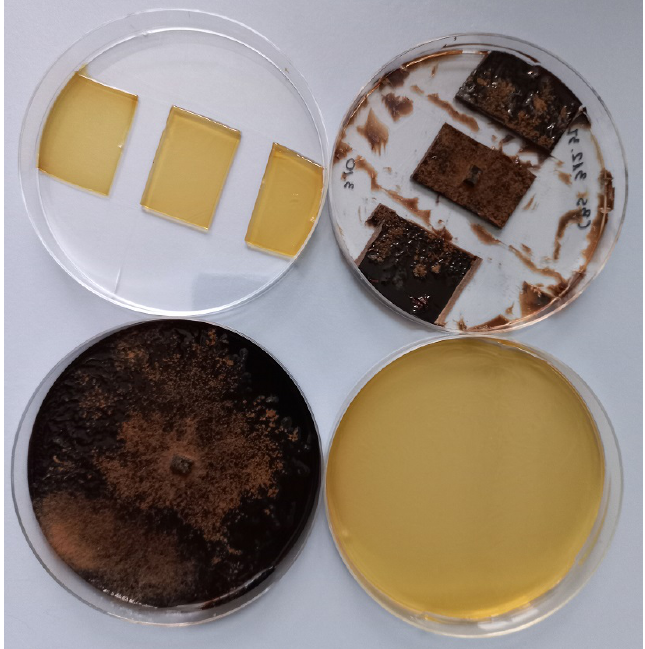
Figure 5. Exemplary photo of the experimental variants of Petri dishes containing measured samples. Ciboria —brown,